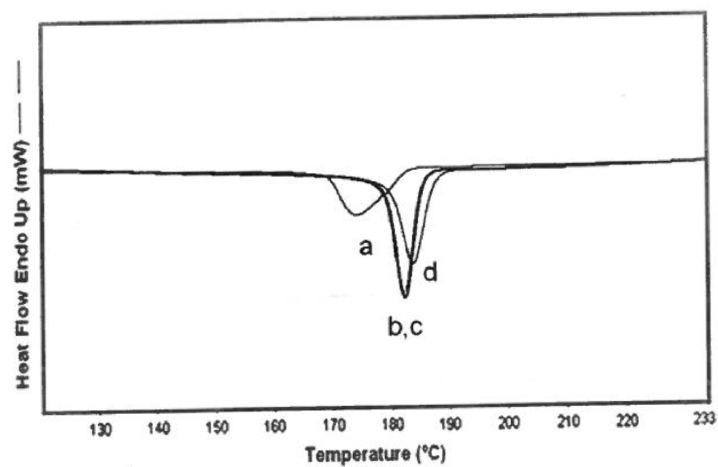
Figure 9. DSC cooling scans for ( a ) neat nylon-6 sample (600,000 g/mol), with 2 wt % of ( b ) nylon-6